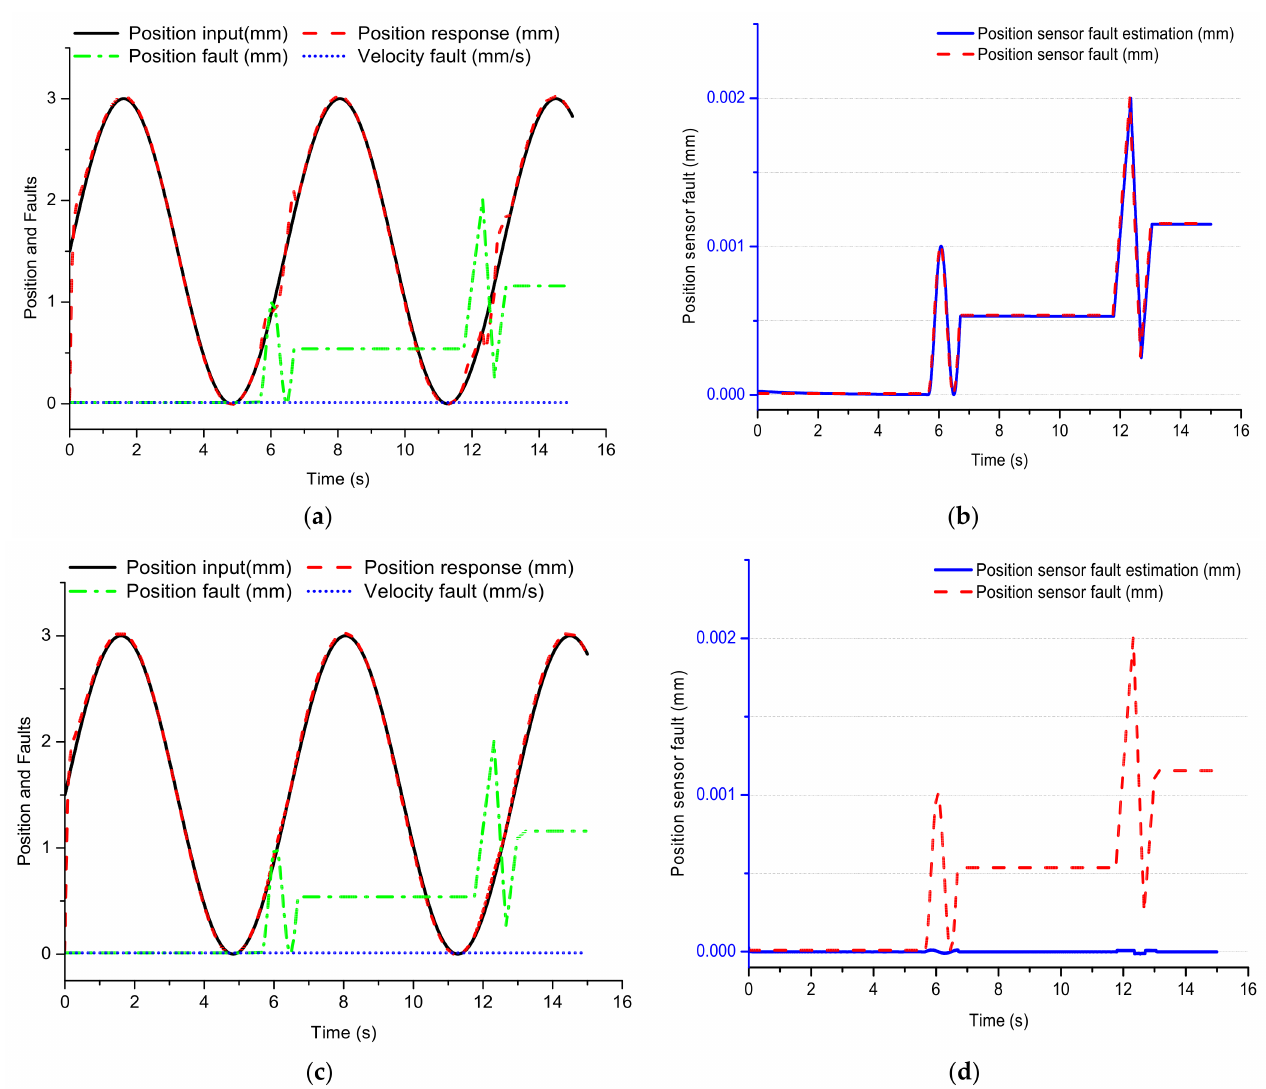
Figure 4. Simulation results of EHA system under the position sensor fault impact. ( a ) Position response for the case without position sensor fault compensation. ( b ) Position sensor fault estimation for the case without position sensor fault compensation. ( c ) Position response for the case with position sensor fault compensation. ( d ) Position sensor fault estimation for the case with position sensor fault